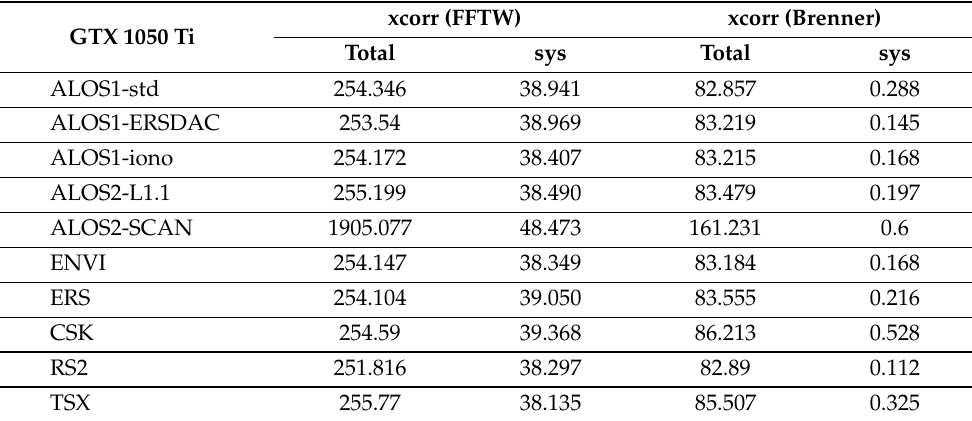
Table 6. Execution times for xcorr using FFTW and Brenner FFT on GTX 1050 Ti hardware configura- tion. Figures are expressed in seconds, and the sys column presents the fraction of the total spent in Supervisor mode, also in seconds.